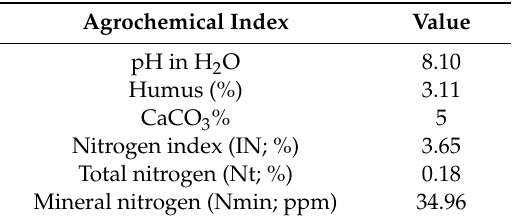
Table 1. Soil characteristics in the experimental site 1 .